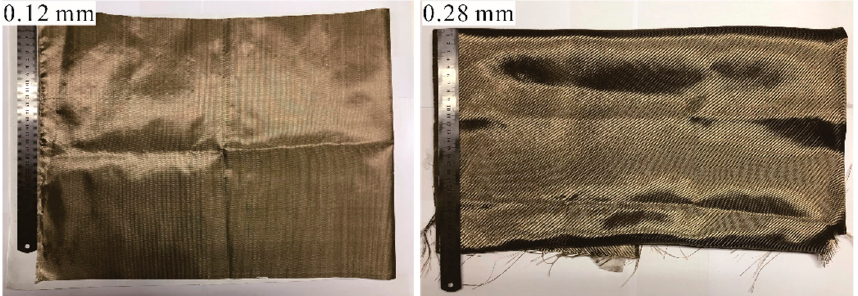
Figure 2. Basalt fiber cloths.